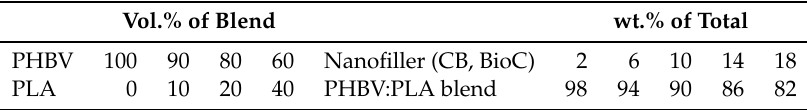
Table 1. PHBV:PLA composite blend ratios with CB and BioC nanofiller.